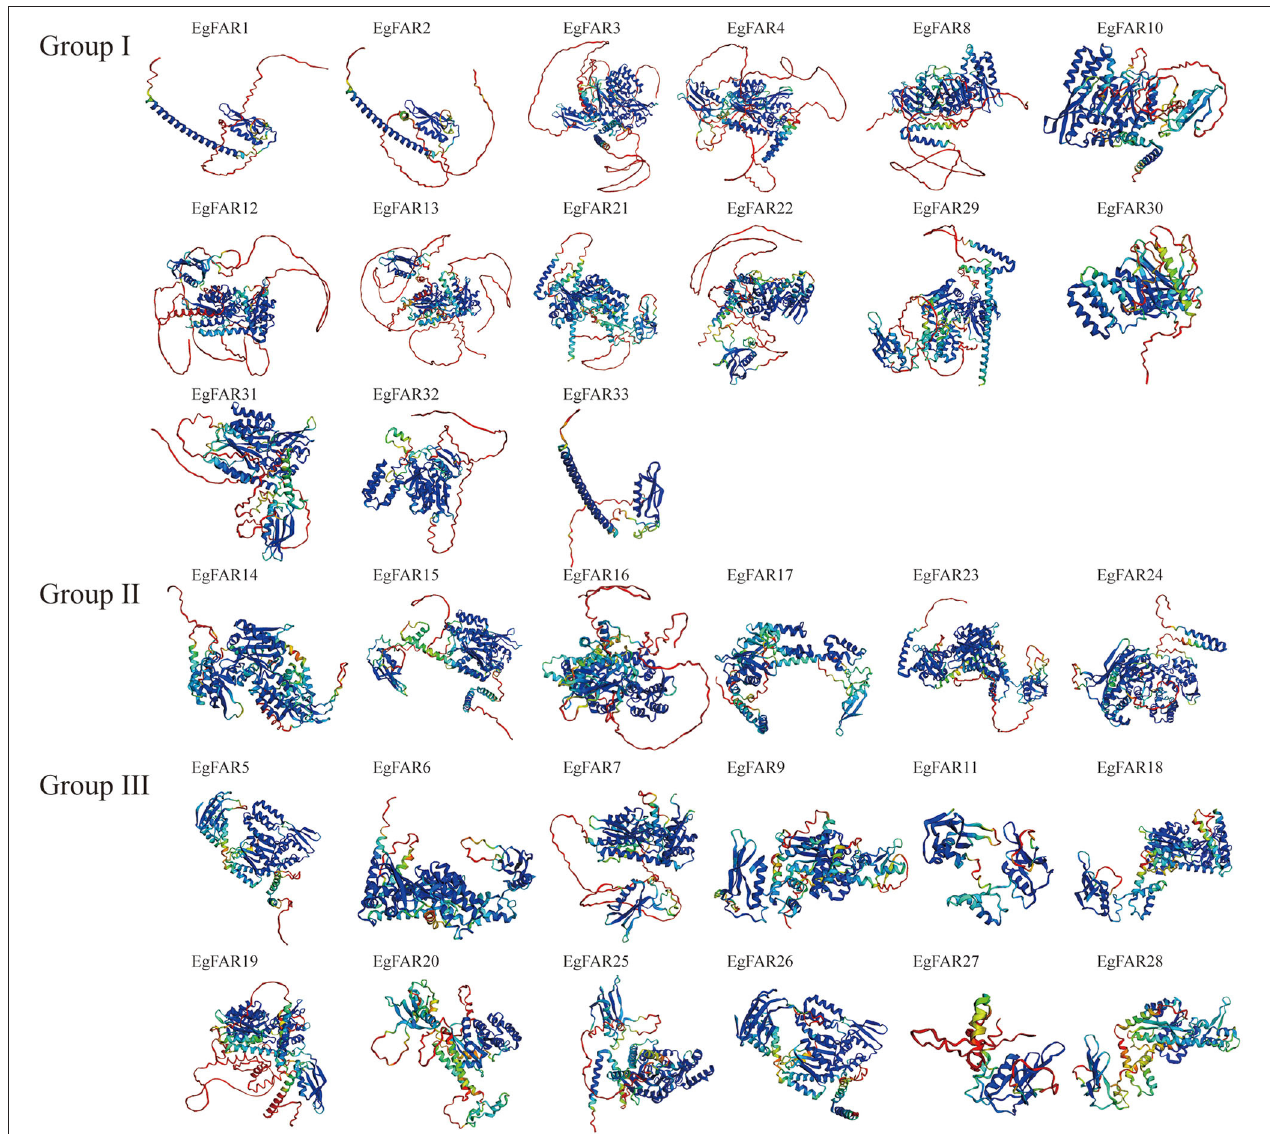
FIGURE 4 | Three-dimensional models of EgFAR1/FHY3 proteins. Blue indicates high quality, whereas red indicates low